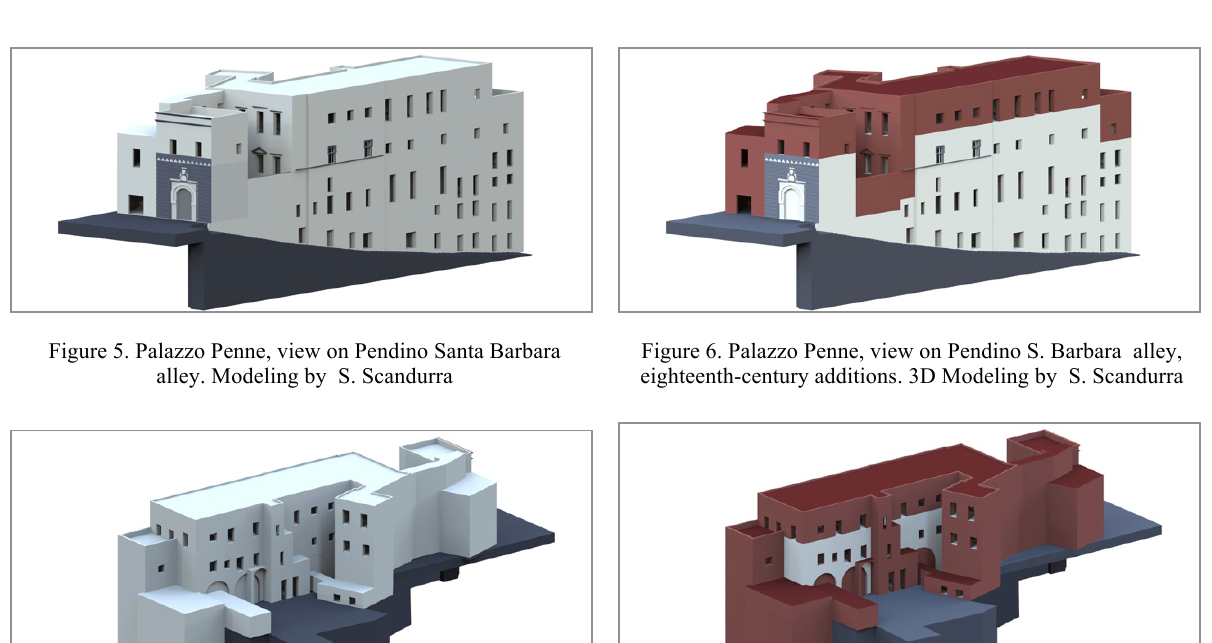
Figure 7. Palazzo Penne, view of the internal courtyard. Modeling: S. Scandurra